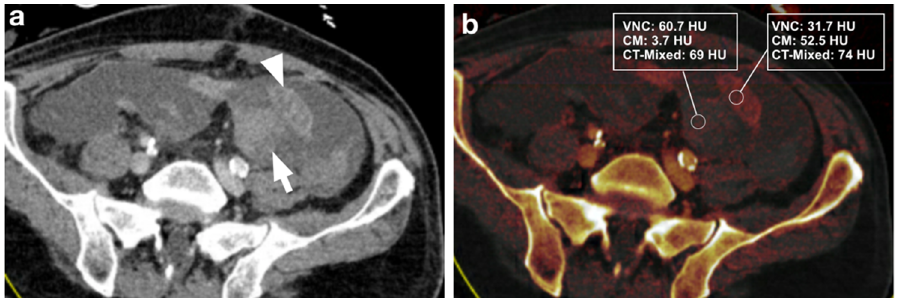
Figure 5. 63-year-old male patient after a two-stage colectomy following mesenteric infarction with intestinal ischemia. ( a ) Intra-abdominal hematoma (arrow) adjacent to a small bowel loop (arrowhead). ( b ) Measurement of iodine maps shows a difference in VNC and iodine values (dual-energy CT) between hematoma and intestinal loops, but no difference in DE-LB.